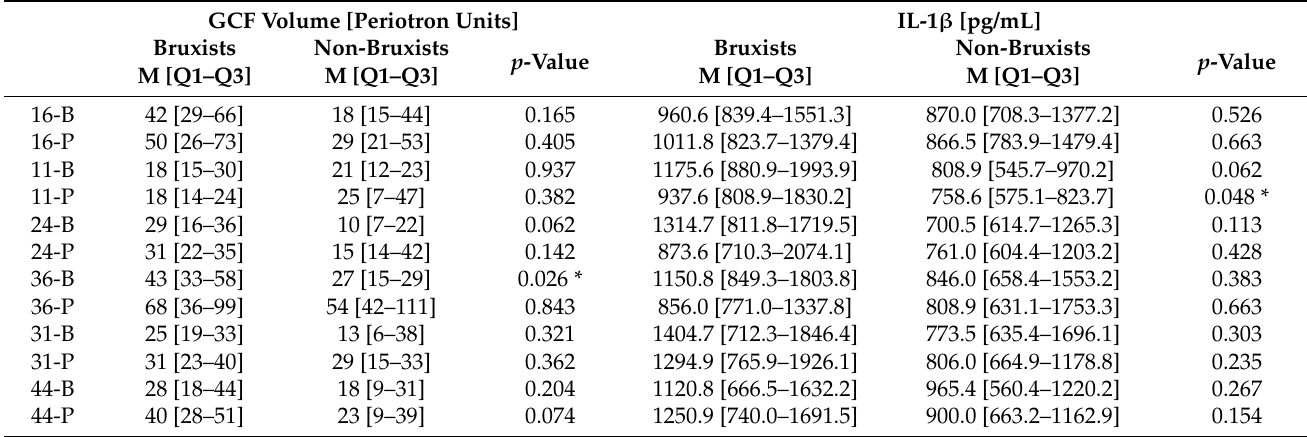
Table 3. Results comparing bruxists and non-bruxists.